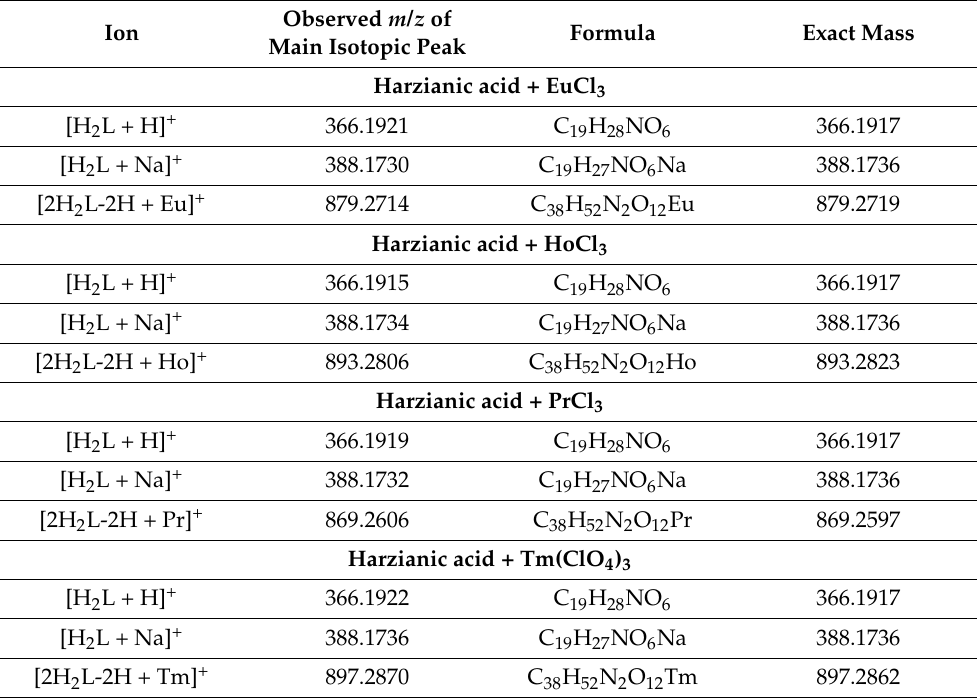
Table 1. Most abundant ions in high-resolution mass spectra (HRMS) acquired by HPLC-ESI-HRMS on solutions of harzianic acid and Pr 3+ , Eu 3+ , Ho 3+ , and Tm 3+ rare-earth cations. Observed m/z of Ion Formula Exact Main Isotopic Peak